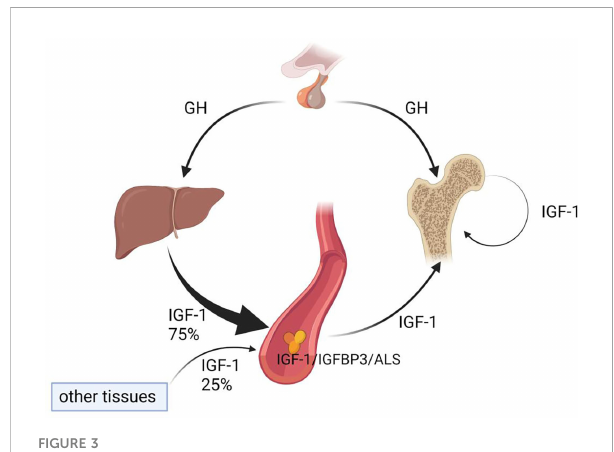
FIGURE 3 Circulating and local IGF-1 both positively effect bone